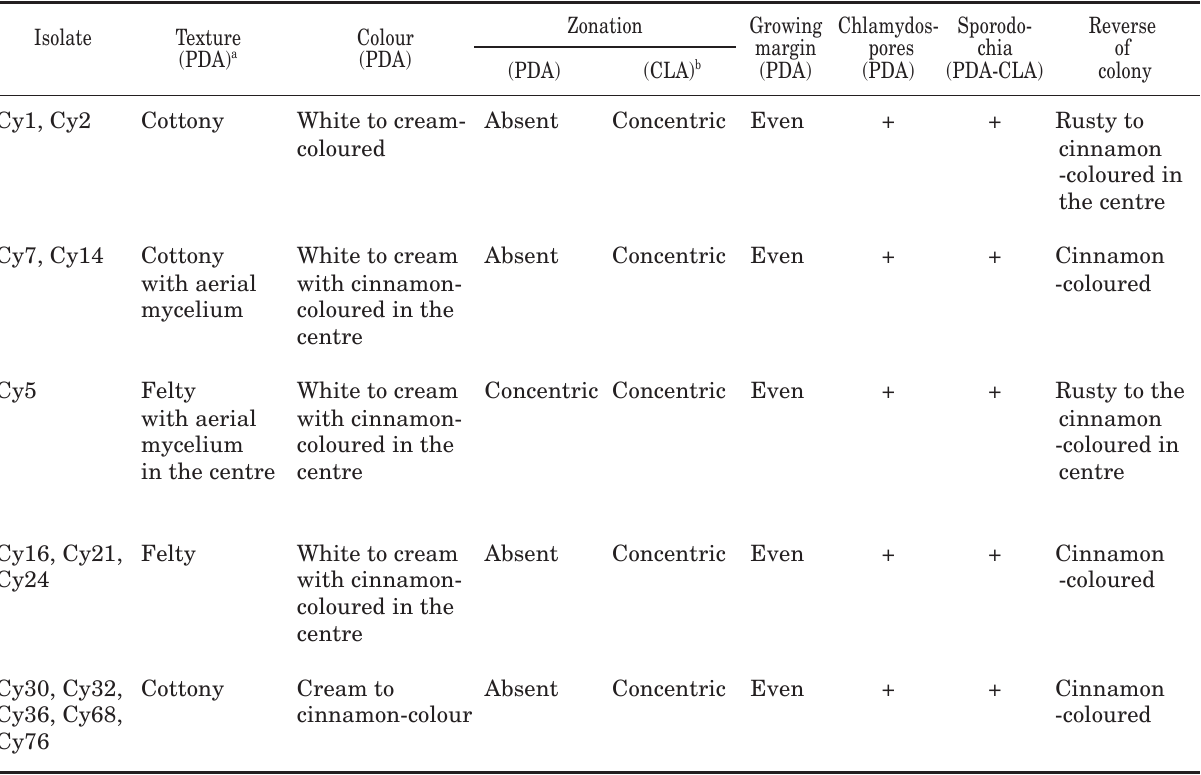
Table 2. Colony characters of Cylindrocarpon destructans